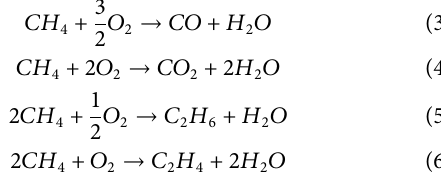
( Supplementary Figure S16 ). To achieve similar conversions the